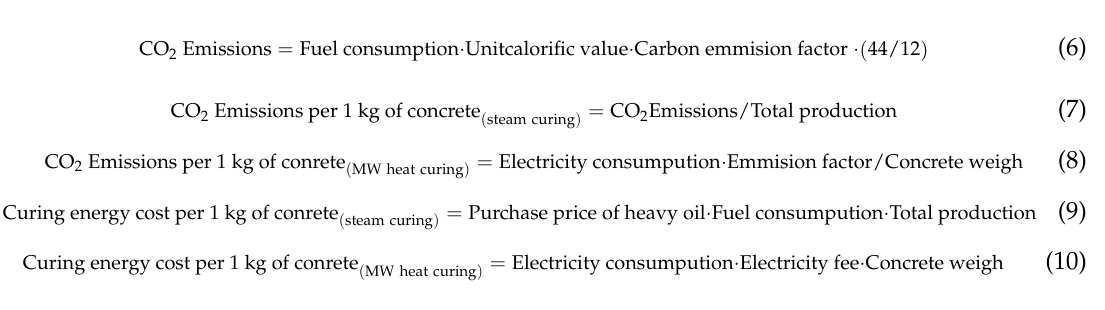
Figure 21. Torrent air permeability.